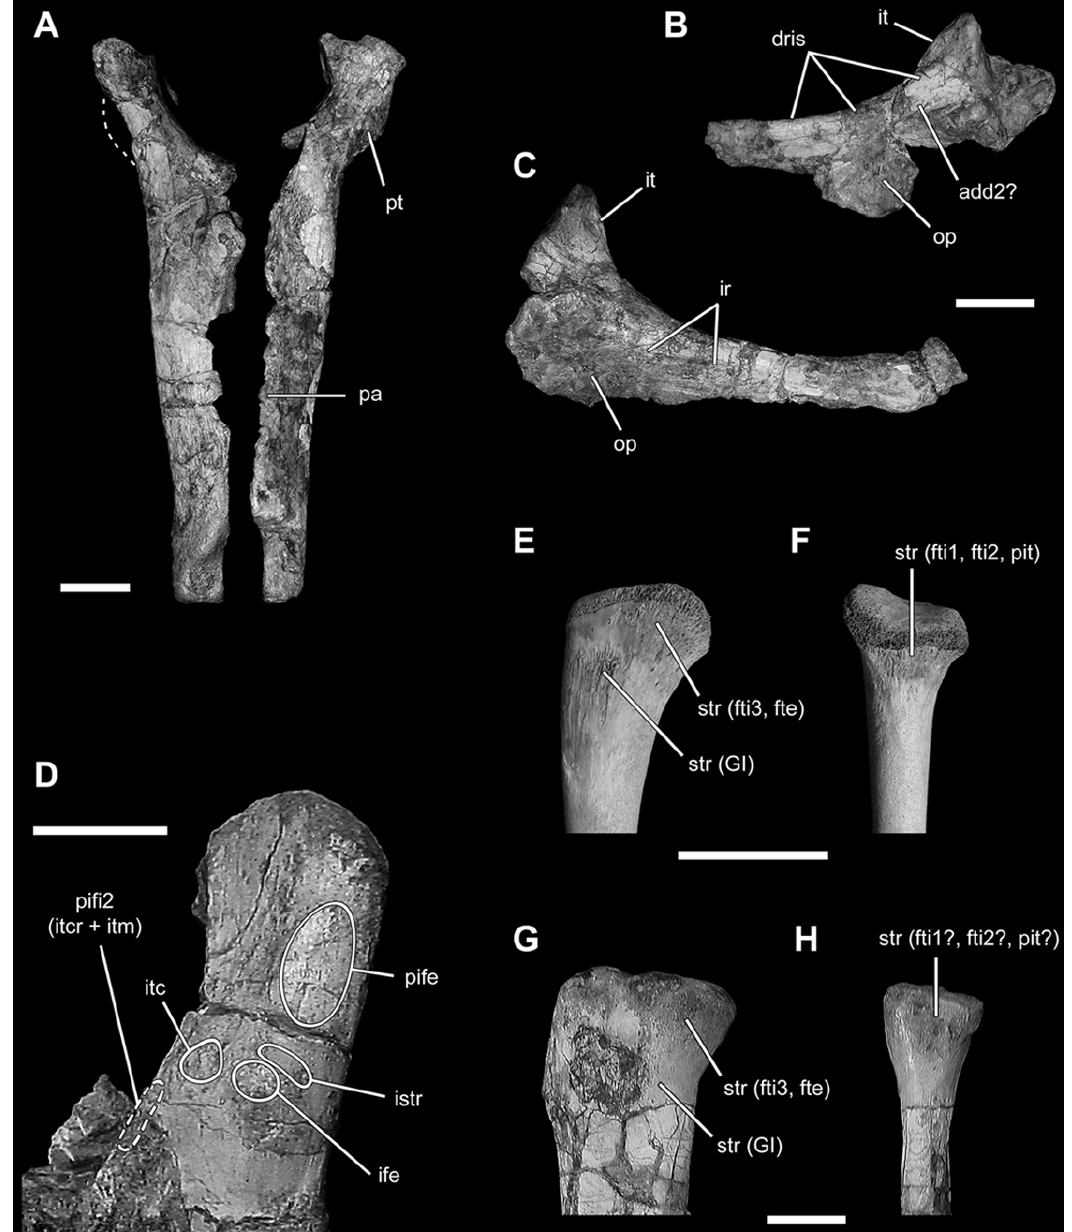
Fig. 5 – Right and left pubis in anterior view (A) indicating the pubic tubercle ( pt ) and the pubic apron ( pa ). Dashed line indicates the supposed position of the unpreserved pt in the right pubis. Right (B) and left (C) ischium in lateral view. The dorsal ridge of the ischium ( dris ), ischial ridge ( ir ), ischial tuberosity ( it ) and obturator process ( op ) are indicated, along with a scar that may indicate the origin of ADD2. Lateral view of the proximal part of the left femur (D) indicating the approximate areas of insertion of the muscles ITC (on the anterior trochanter), IFE (on the trochanteric shelf), ISTR (on a groove proximal to the trochanteric shelf) and PIFE (on the greater trochanter). The probable insertion of PIFI2 is also indicated (on the lateral surface of the anterior keel of the femur). Proximal part of the right tibia of Caiman (E and F) and Staurikosaurus (G and H) in medial (E and G) and posterior (F and H) views: the striations ( str ) in Staurikosaurus are topographically equivalent to the insertions of FTI1-3, FTE, PIT and gastrocnemius internus (GI) in Caiman . Scale bars: 20